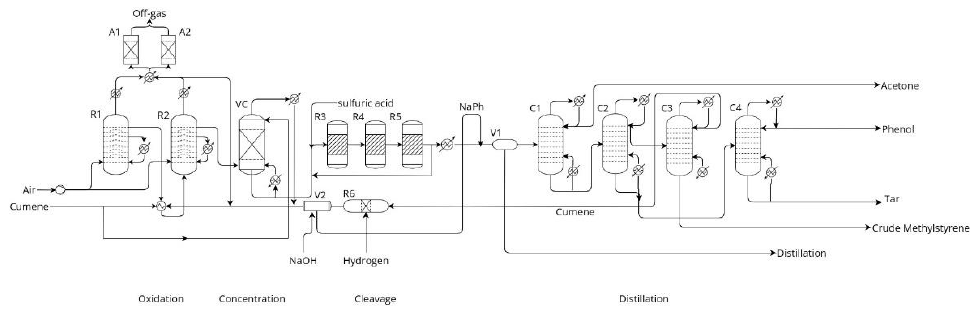
Figure 3. Production of phenol from cumene. R1, R2: cumene oxidation reactors; A1, A2: activated- carbon adsorbers; VC: vacuum distillation column; R3 – R5: cleavage reactors; V1: neutralization drum; C1: acetone column; C2: cumene column; C3: α -methylstyrene column; C4: phenol column; R6: hydrogenation reactor; V2: cumene scrubber [1].